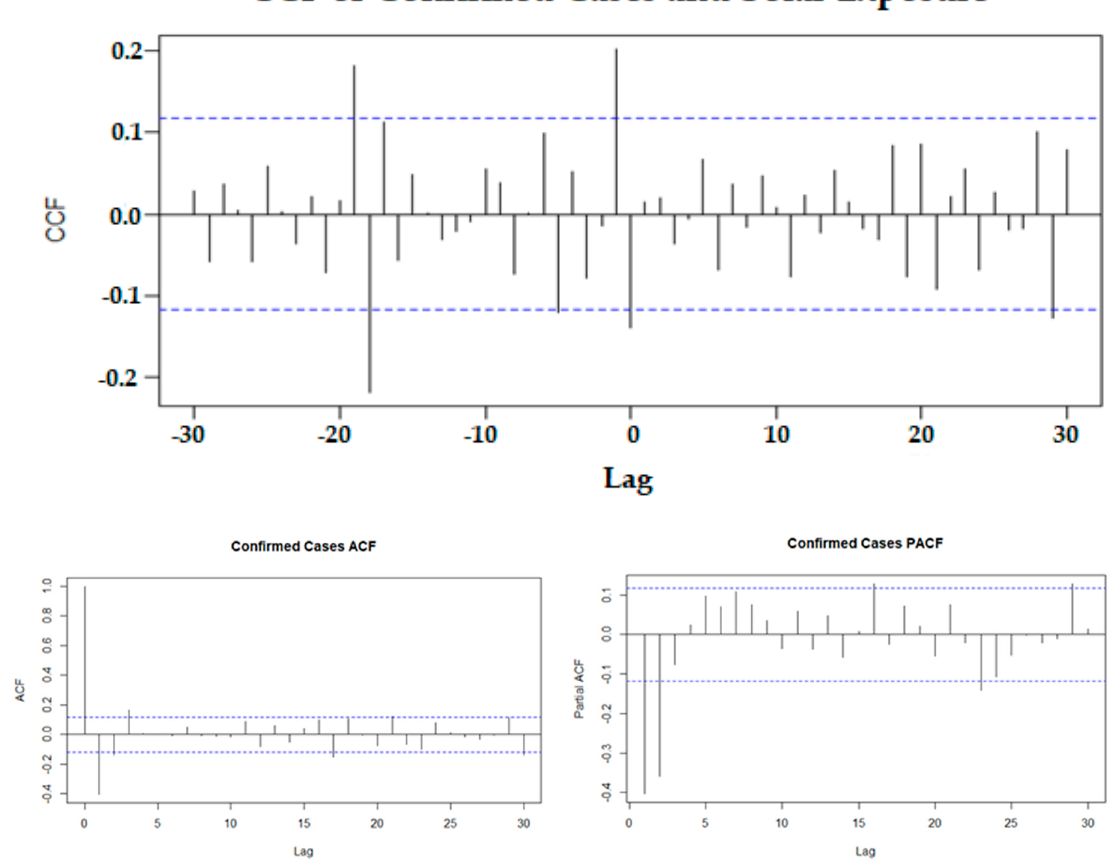
Figure 3. Cross-correlation function (CCF) between confirmed cases and solar exposure (the negative lags indicate that solar exposure is before the confirmed cases) ( top ). Autocorrelation function (ACF) and partial autocorrelation function (PACF) for the stationary confirmed cases ( bottom ).